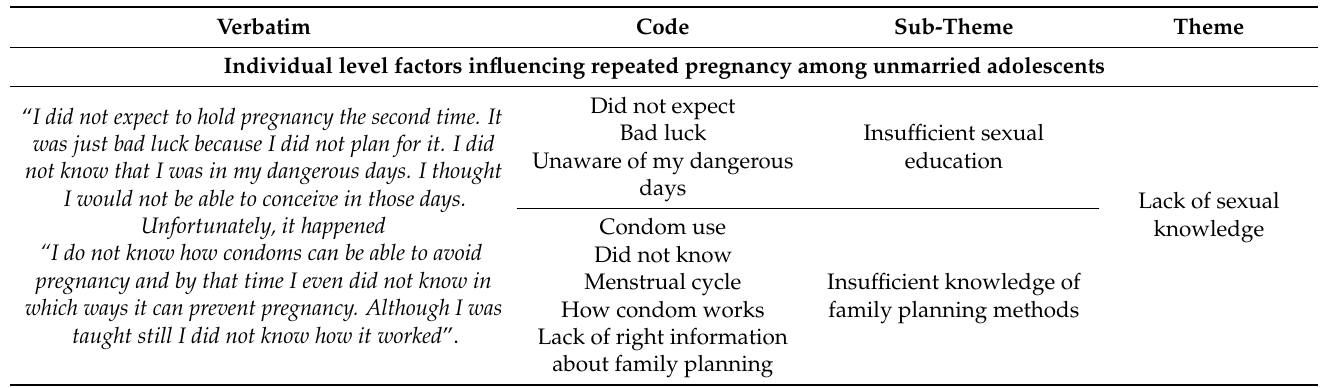
Table 1. Example of thematic